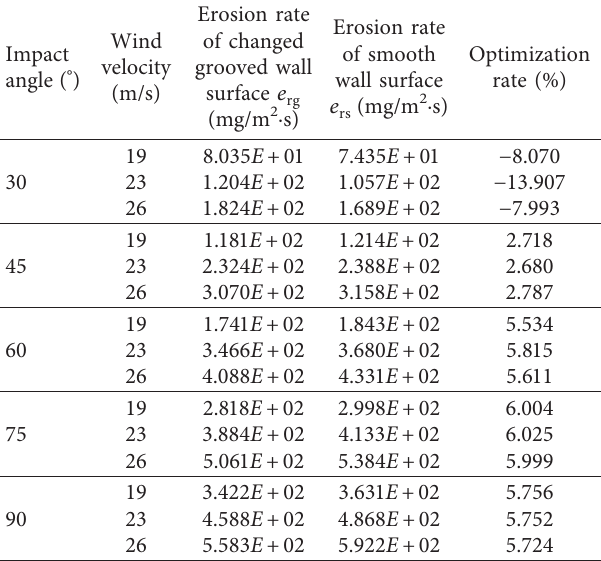
Table 5: Erosion rates of changed grooved and smooth wall surfaces under different wind velocities and impact